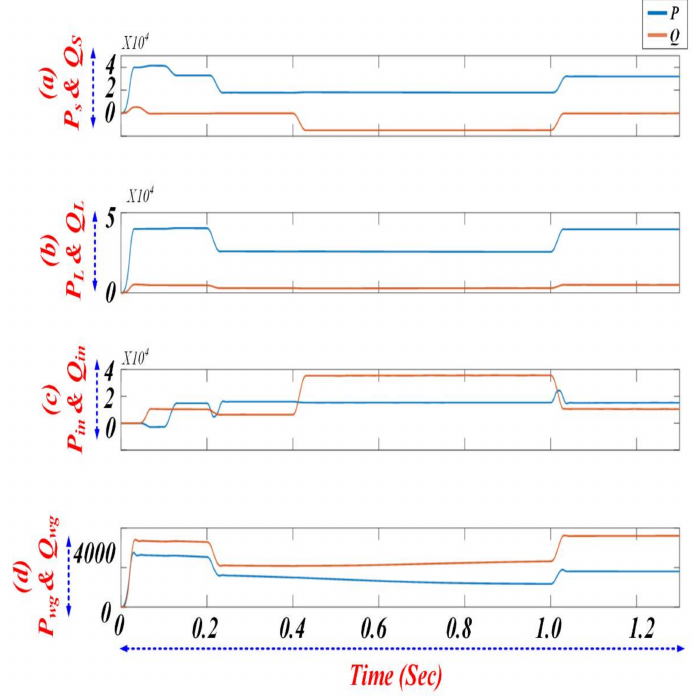
Figure 8. PV-STATCOM performance: ( a ) source powers (P&Q); ( b ) load powers (P&Q); ( c ) PV-STATCOM powers (P&Q); and ( d ) wind generator powers